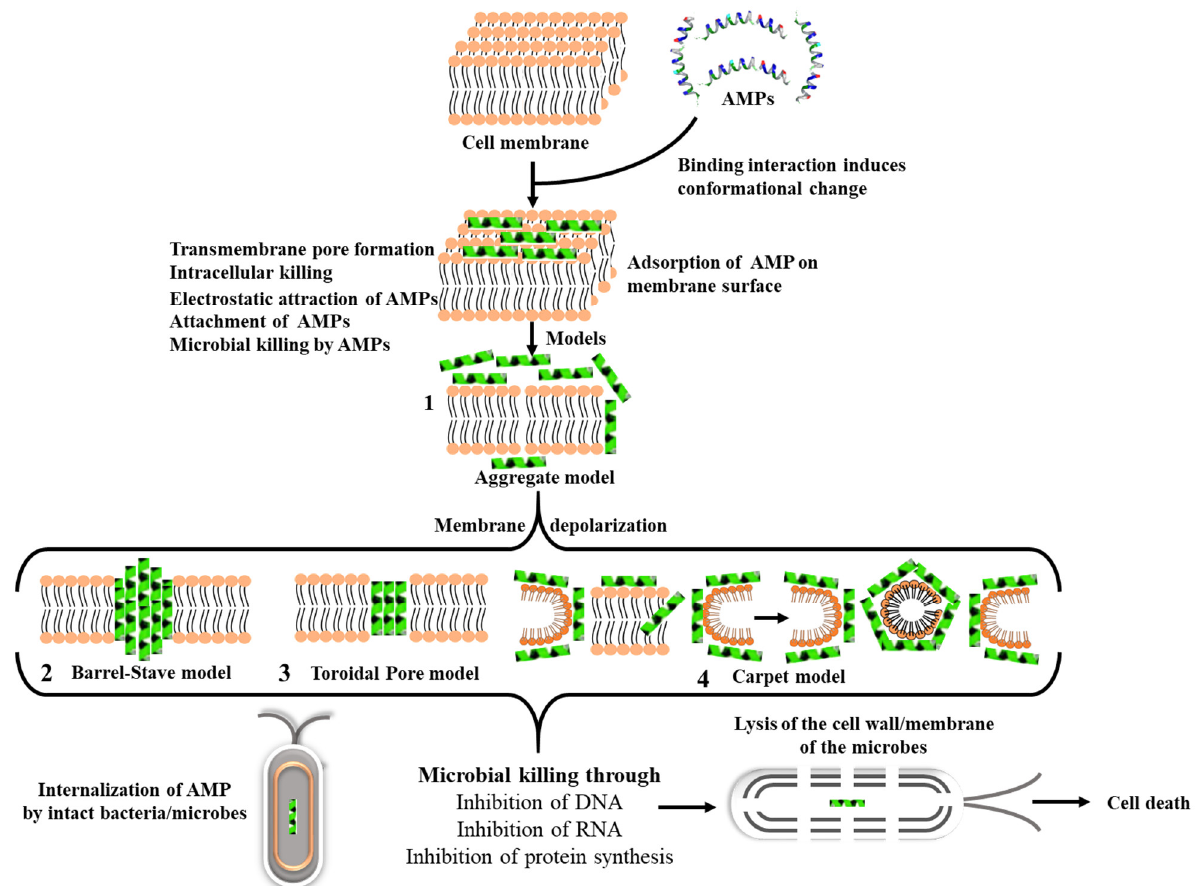
Figure 3. Mode of action used by AMPs to target and disrupt the bacterial membrane, leading to cell lysis and bacterial death.